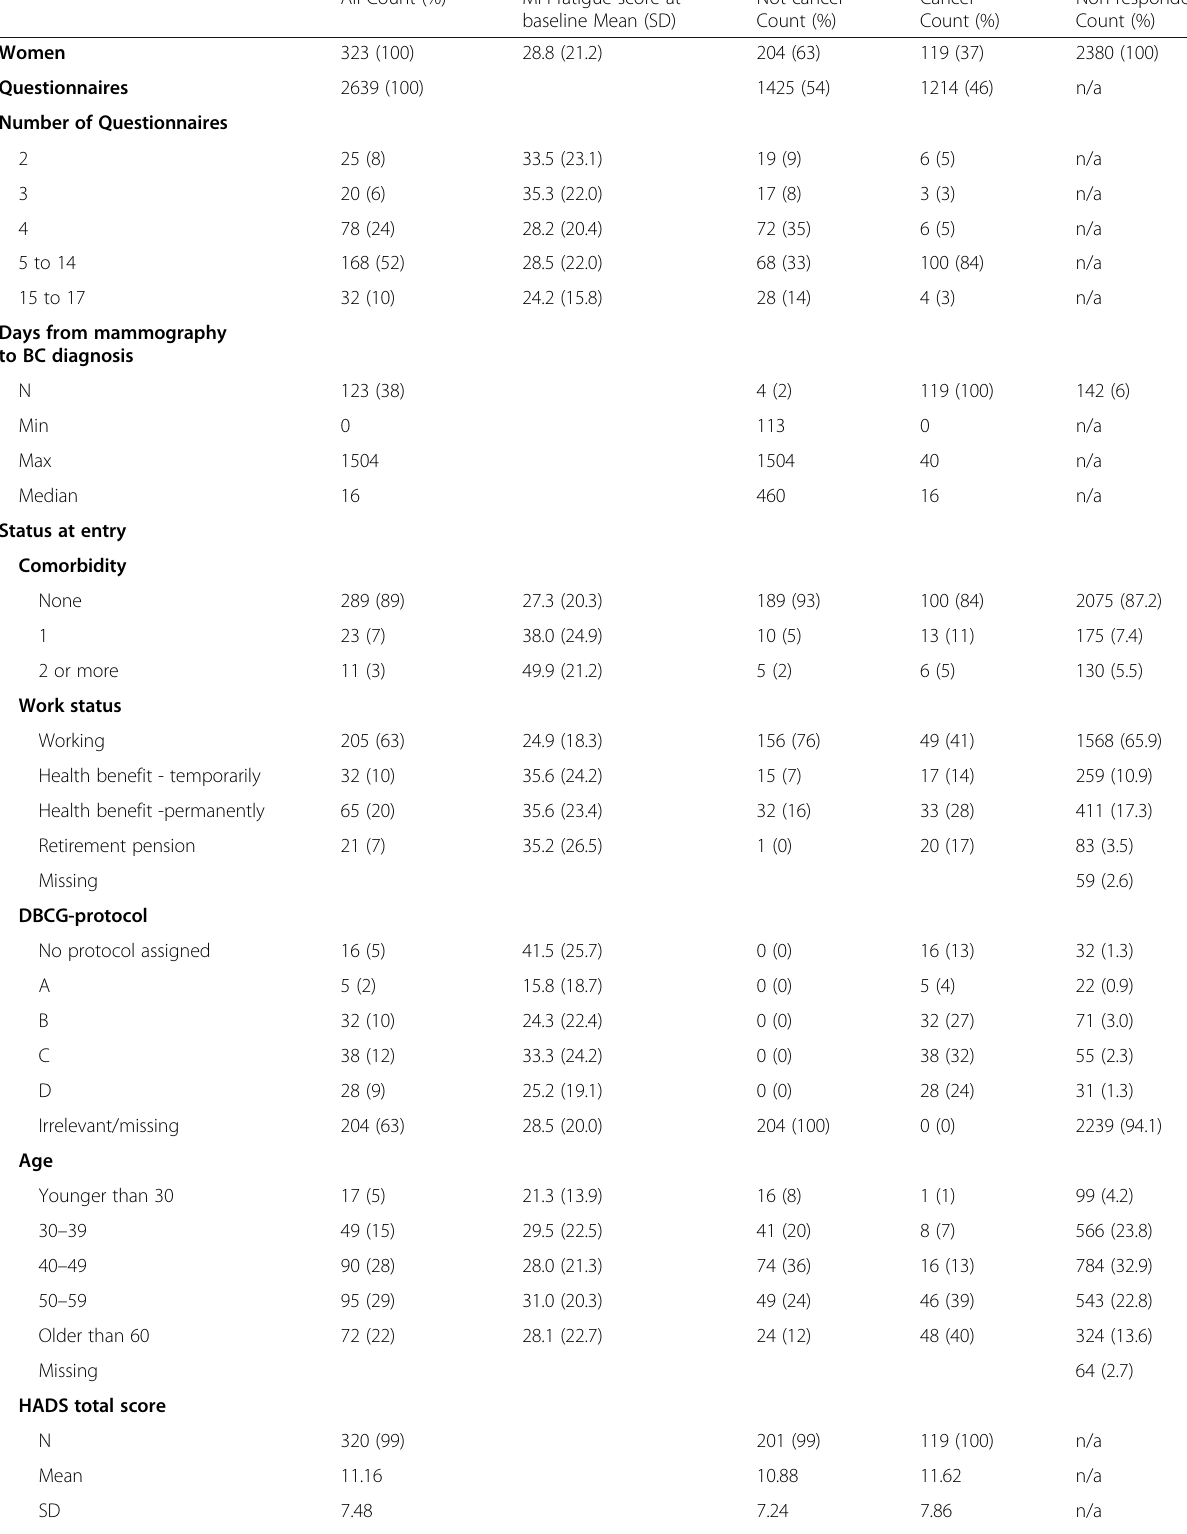
Table 1 Characteristics of women at the time of mammography categorized by cancer